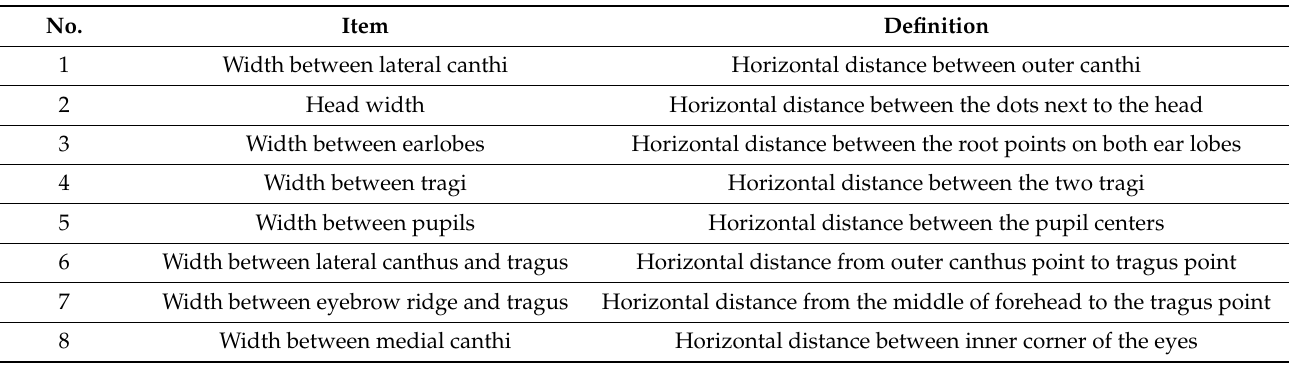
Table 1. Definitions of representative items from Figure